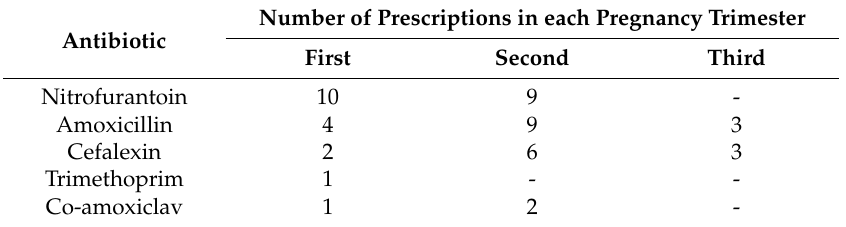
Table 3. Antibiotic prescribing according to trimester of pregnancy.